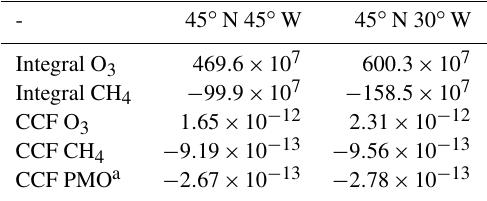
Table 1. The integrated O 3 and CH 4 contribution to atmospheric concentration for both locations given in Fig. 1. The first location (45 ◦ N 45 ◦ W) is west of and the second location (45 ◦ N 30 ◦ W) within a high-pressure ridge. Additionally, the resulting climate im- pact for both locations, represented by climate change functions (CCFs), is given. For further details on the climate impact, see Frömming et al. (2020). Integrals are given in kgd − 1 and CCF val- ues are given in Kkg(N) − 1 .